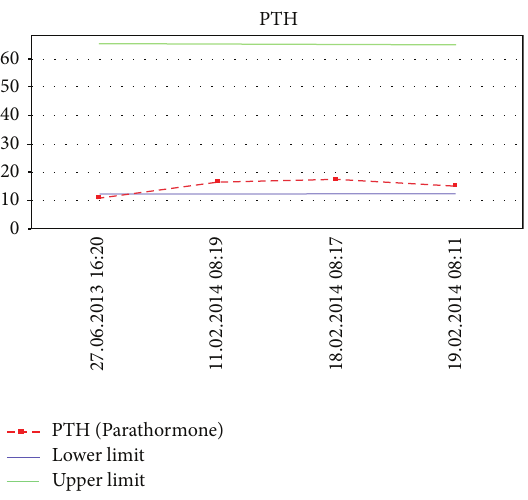
Figure 2: Course of serum parathyroid hormone concentrations. Erythrocyte sedimentation rate and ANA level were normal, ruling out inflammatory and rheumatic diseases. Thyroid- stimulating hormone and free thyroid hormones should be checked to help rule out hyperthyroidism. Free T 4 , Free T 3 , and TSH were normal, ruling out hyperthyroidism, and there were no signs or symptoms suggestive of Cushing disease, adrenal insufficiency, acromegaly, or pheochromo- cytoma. Normal prolactin level and IGF-I in the age- and gender-matched normal range excluded the diagnosis of prolactinoma and acromegaly in our patient,